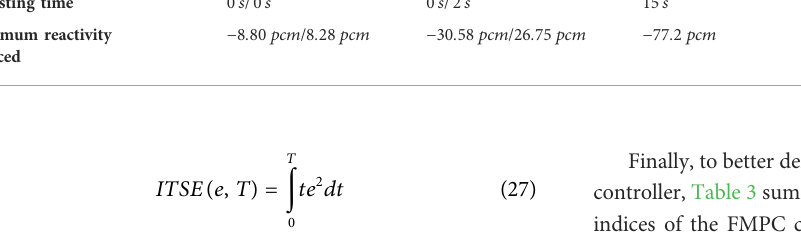
Globe ramp Local ramp (power lever (power lever decline/rise) decline/rise)